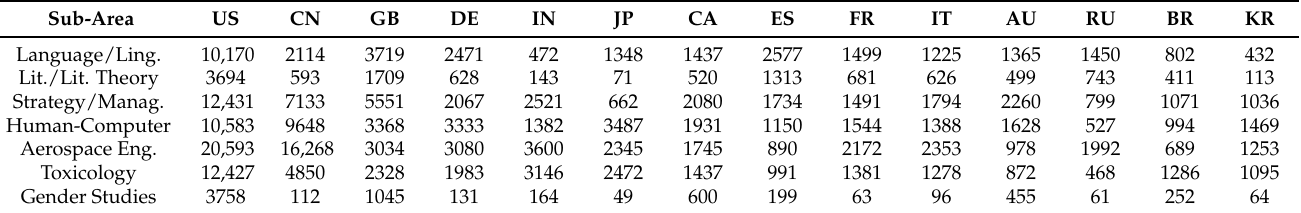
Table 2. Number of publications (sum over sample years 1990, 2000, 2010 and 2020) in the selected Scopus sub-areas by country with the following abbreviations: US—United States,